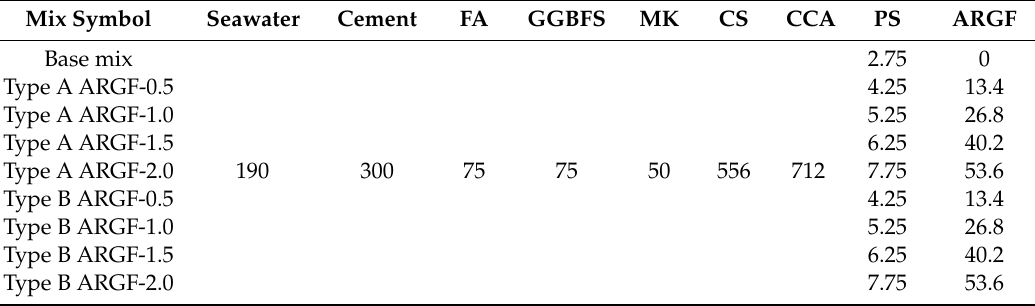
Table 3. Mix proportion (kg / m 3